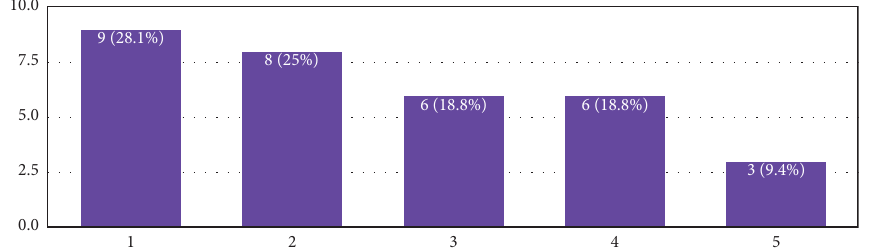
Figure 3: In this fgure, on the X -axis, 1 represents “not familiar at all,” 5 represents “very familiar,” and the remaining are the extrapolations in the middle as per the Likert scale. Te Y -axis is the number of responses.